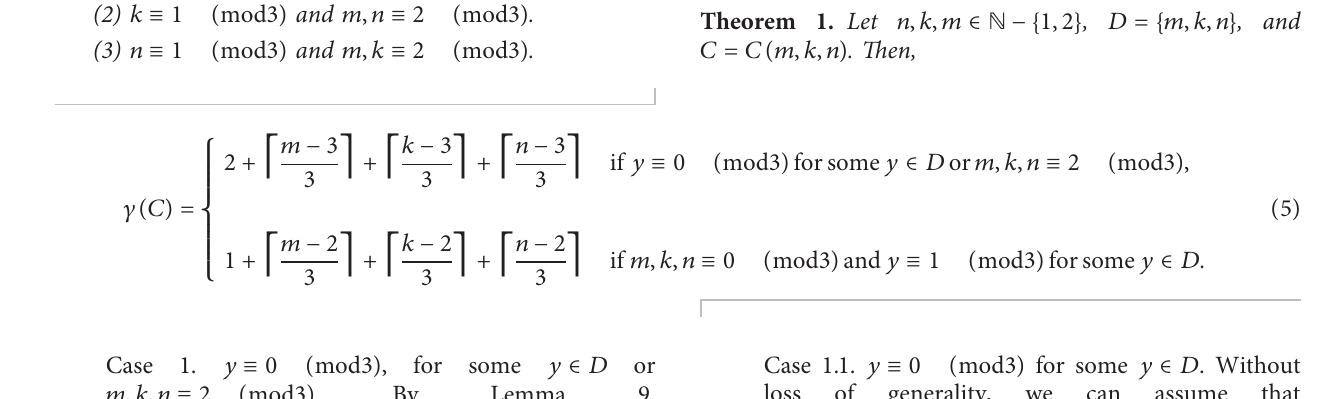
Figure 9: C ( m,k, n ) − N [ 2